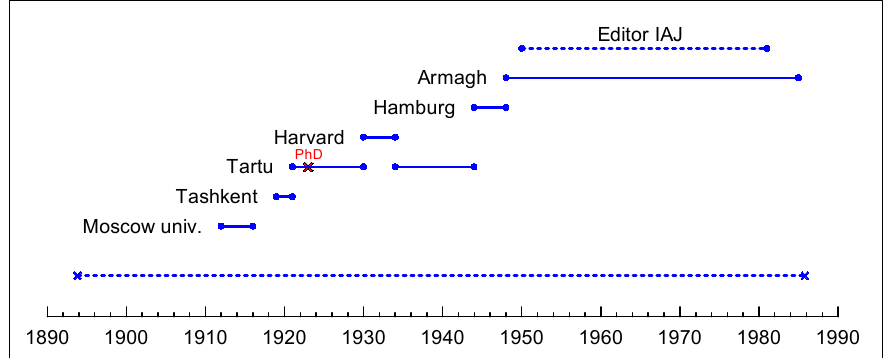
Fig. 1. Timeline of Ernst Julius ¨Opik’s professional